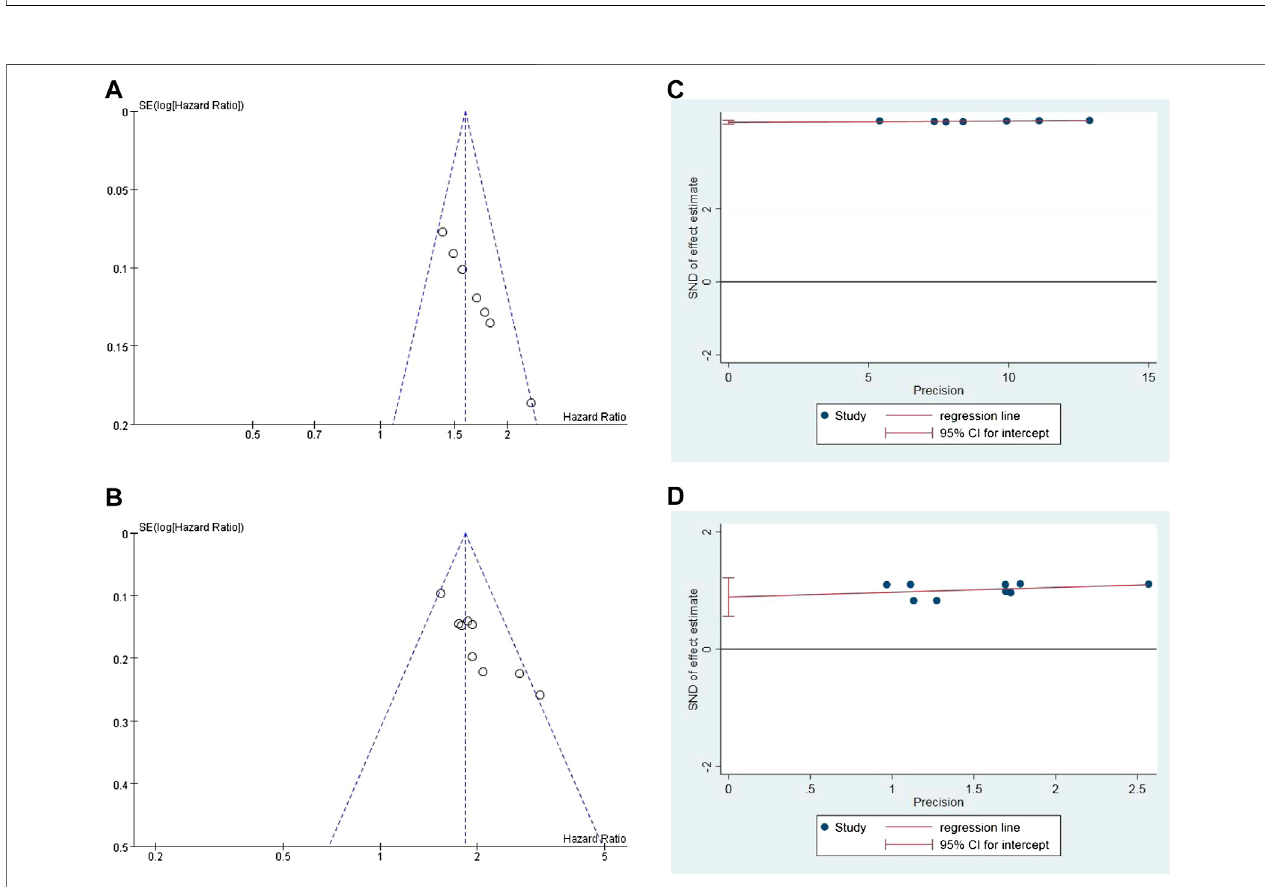
FIGURE 9 | Inverted funnel plot of OS (A) and PFS (B) . Egger test of OS (C) and PFS (D) .